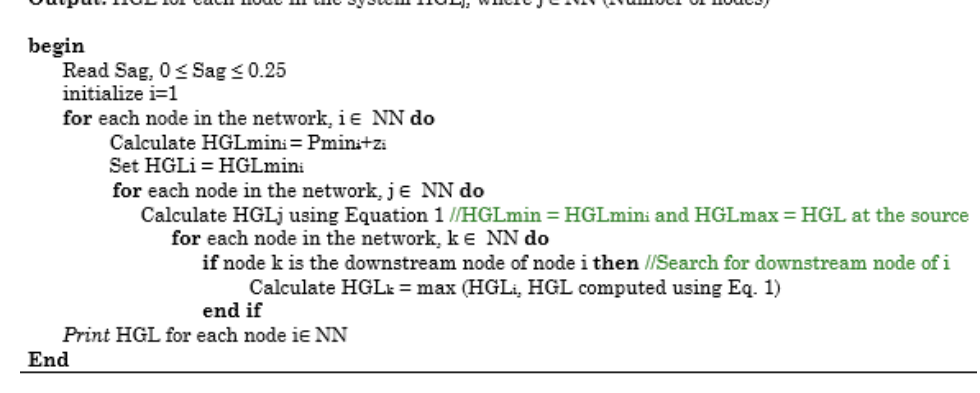
Figure 5. Algorithm for OPUS subprocess.